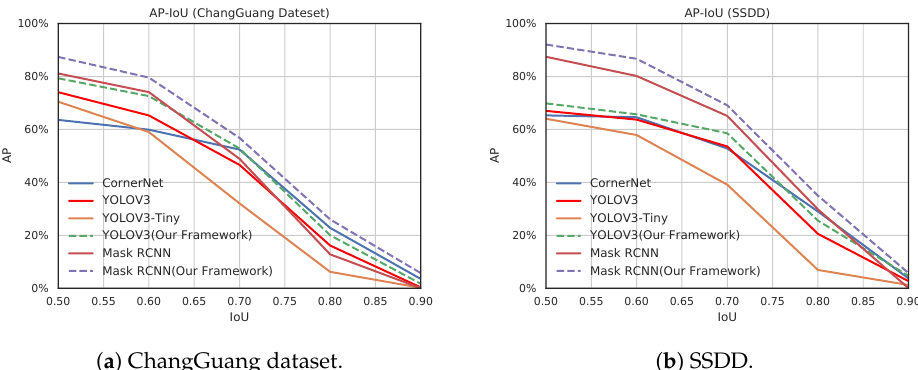
Figure 11. Average precision–intersection over union (AP–IoU) curves for the two datasets. Plotted re- sults show the detection performance of our detection framework and some representative detec- tion methods.